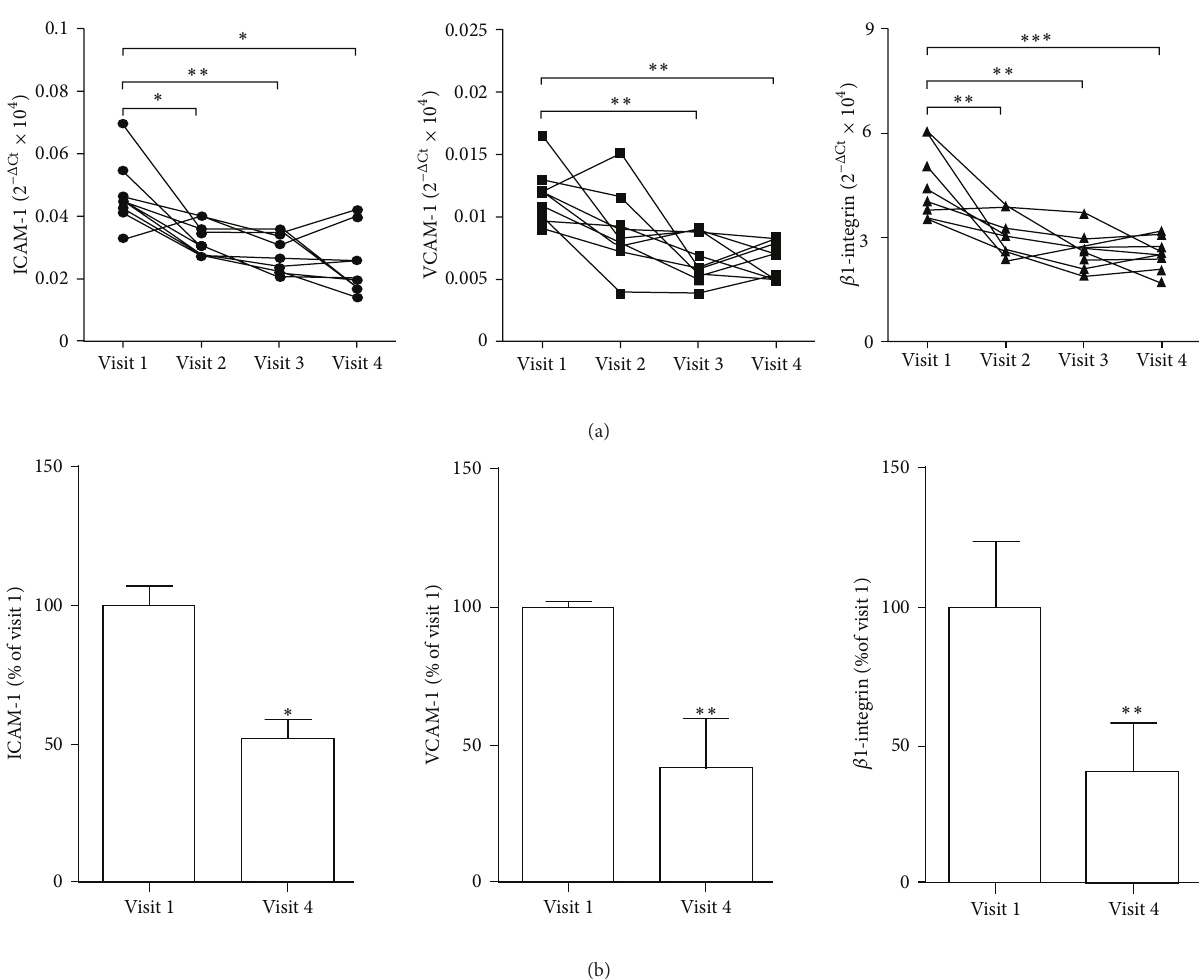
Figure 1: (a) ICAM-1 (circle), VCAM-1 (square), and 𝛽 1-integrin (triangle) mRNA levels in cEC obtained from venous blood of PAD patients at the different visit times. (b) % of reduction of mRNA levels of ICAM-1, VCAM-1, and 𝛽 1-integrin in cEC at visit 4 with respect to visit 1. ∗ 𝑃 < 0.05 , ∗∗ 𝑃 < 0.01 , and ∗∗∗ 𝑃 < 0.001 versus visit 1.